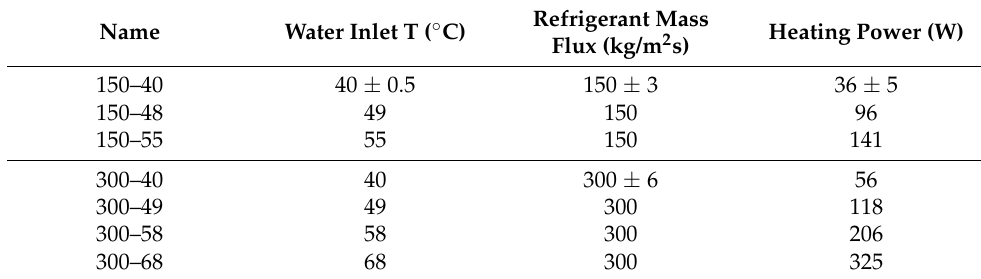
Table 2. Experimental cases. Uncertainties stated in the first row apply to the whole